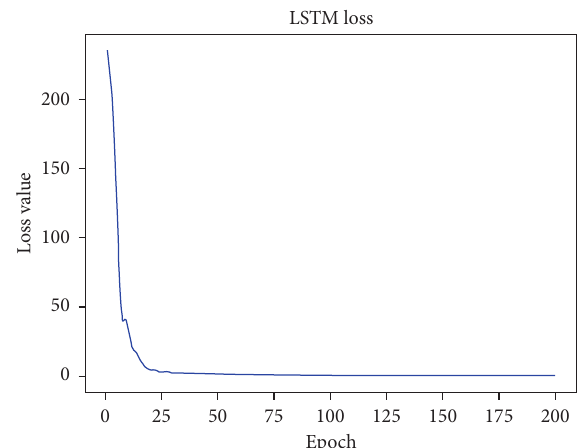
Figure 4: Trend of the loss function of the LSTM training set.